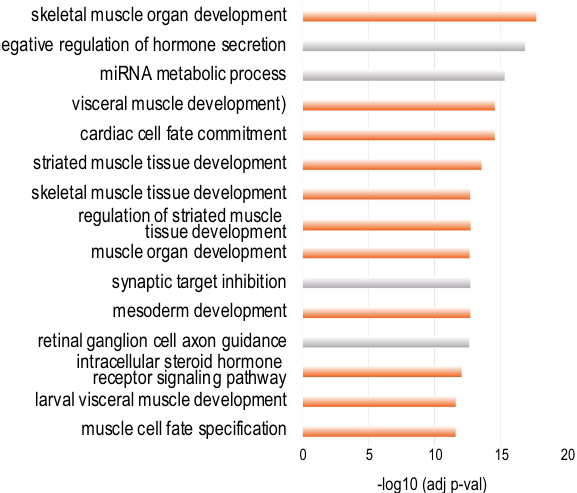
Figure 8. The Yorkie and Scalloped transcriptional complex regulates muscle-specific gene expression during flight muscle growth. ( a ) Using AnnoMiner’s peak integration function with ChIP-seq data from Yorkie (modENCODE ENCFF708VEF) and Scalloped (modERN ENCFF664CDO) we found high base-pair coverage of both TFs in the TSS (− 2000 to + 500 bp of the Transcription Start Site) of putative target genes. We selected these peaks from both TFs and integrated them with flight muscle specific BRB-seq data ( 47 and GEO dataset GSE158957) isolated from a yorkie loss-of-function muscles at 24 h APF ( b ) or yorkie gain-of-function muscles at 24 h ( c ) and 32 h APF ( d ). The direct Yki/Sd targets Tm1 and Msp300 were downregulated in yorkie loss-of- function at 24 h APF. Only scalloped was identified as upregulated direct target from 24 h yorkie gain of function muscles. At 32 h, 177 genes were identified as potential direct Sd/Yki targets, many of which have muscle-related functions (see also Supplementary Table